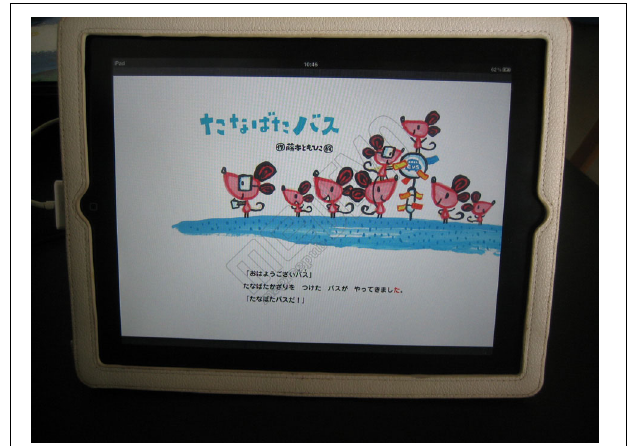
FIGURE 1 | Cover page of the digital version of “Tanabata Basu” presented on an iPad. Note that a single character is presented in red color. At this moment, the narrator pronounces the syllable exactly corresponding to this kana character (ta), and this can be heard from the speaker of the